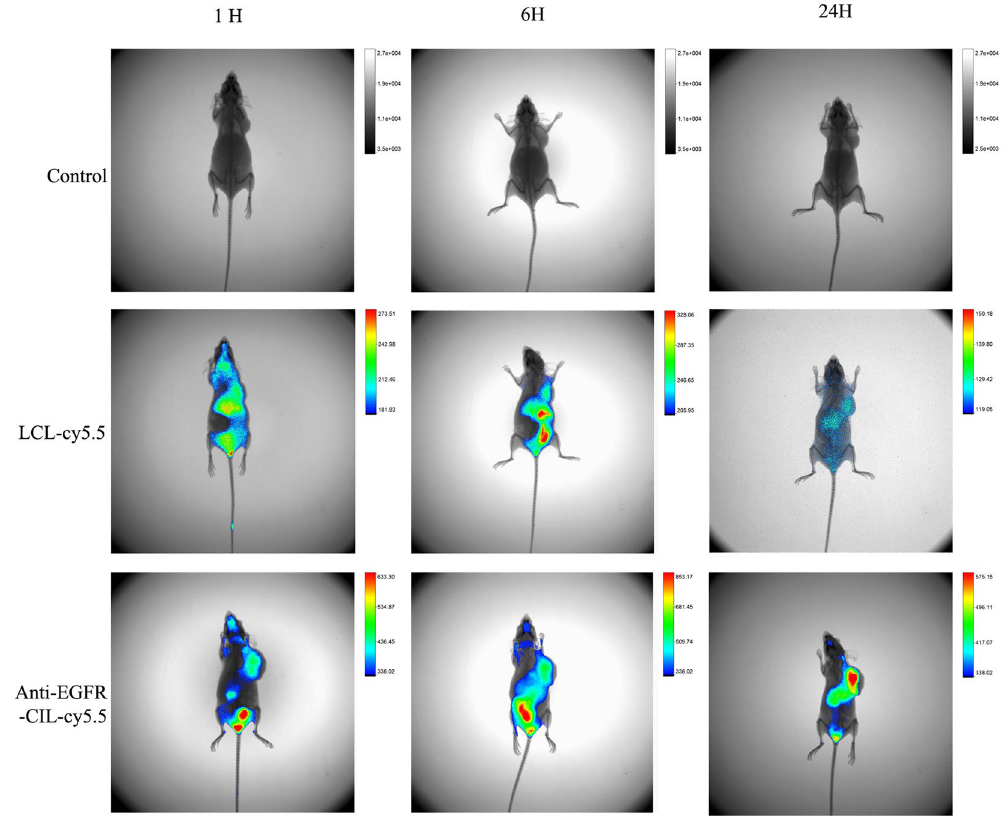
Figure 8. LCL-miR-Cy5.5 and Anti-EGFR-CIL-Cy5.5 were injected through the tail vein at a dose of 1.5 mg/kg mouse weight. After 30 minutes and 1, 6, and 24 hours post-injection, mice were sacrificed, and tumour tissues were analysed using an imaging system.